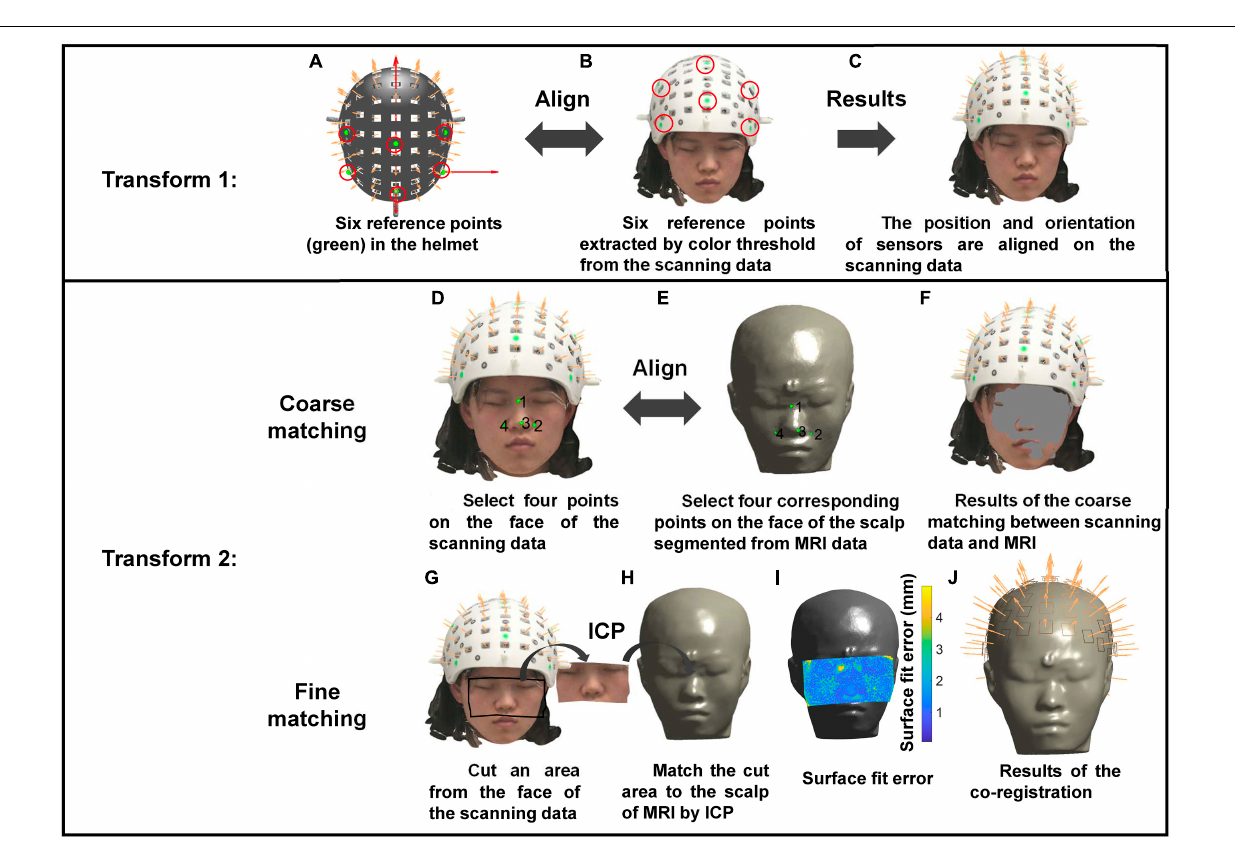
FIGURE 3 | The operation process of the co-registration using the structured-light scanner. Transform 1: Align six reference points on the helmet (A) and those extracted by color threshold from the scanning data (B) to let the positions and orientations of sensors be aligned on the scanning data (C) . Transform 2: Perform coarse matching (D–F) and fine matching (G–I) successively to complete the co-registration. (J) The co-registration